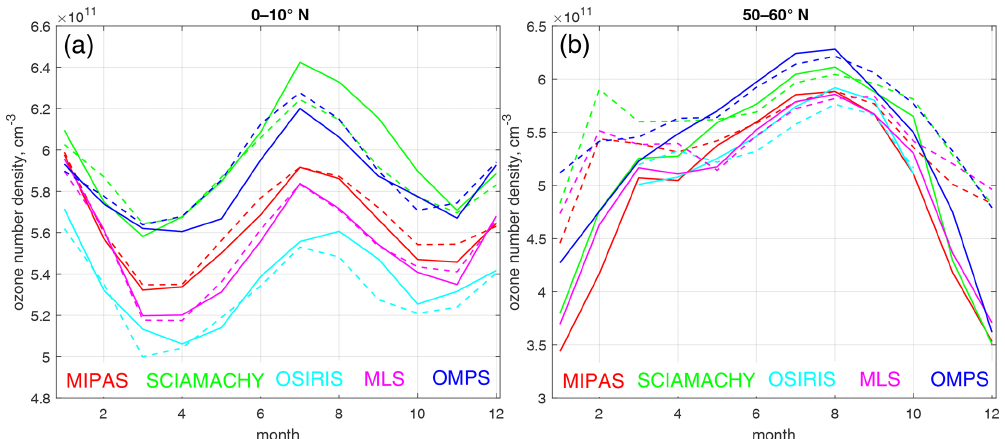
Figure 3. Examples of seasonal cycles in the tropics (a) and NH upper stratosphere (b) at 40km. Solid lines: longitudes 0–20 ◦ E; dashed lines: longitudes 120–140 ◦ E. In the tropics, a semi-annual cycle is observed.